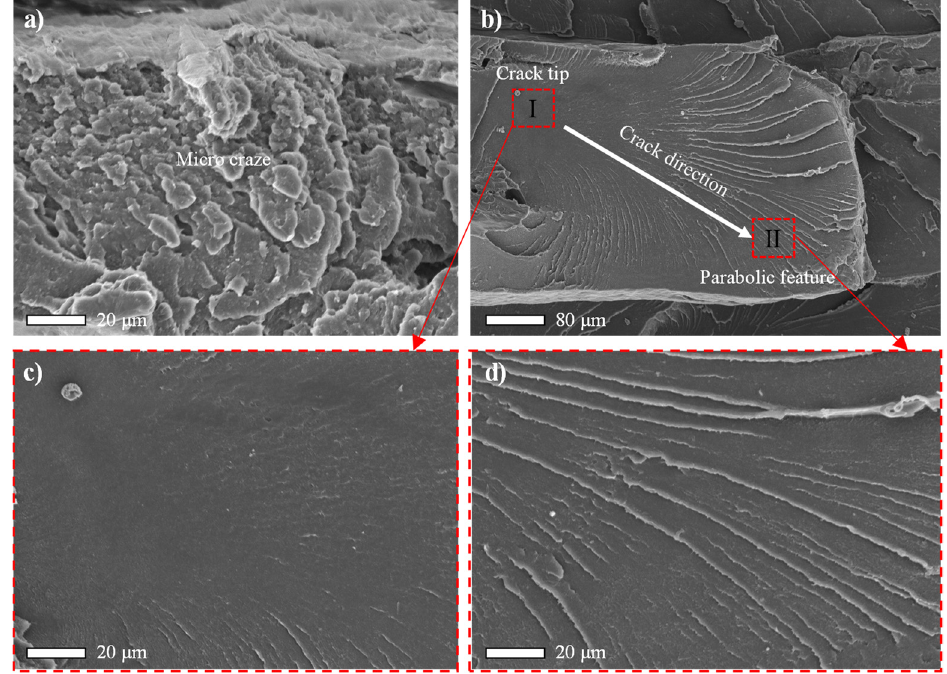
Figure 9. SEM pictures of fracture mechanism. ( a ) The magnified view of area ‘A’ in Figure 8a; ( b ) the magnified view of area ‘B’ in Figure 8d; ( c ) the magnified view of crack tip region ‘I’; ( d ) the magnified view of parabolic crack growth region ‘II’. White arrow indicates the crack propagation direction.